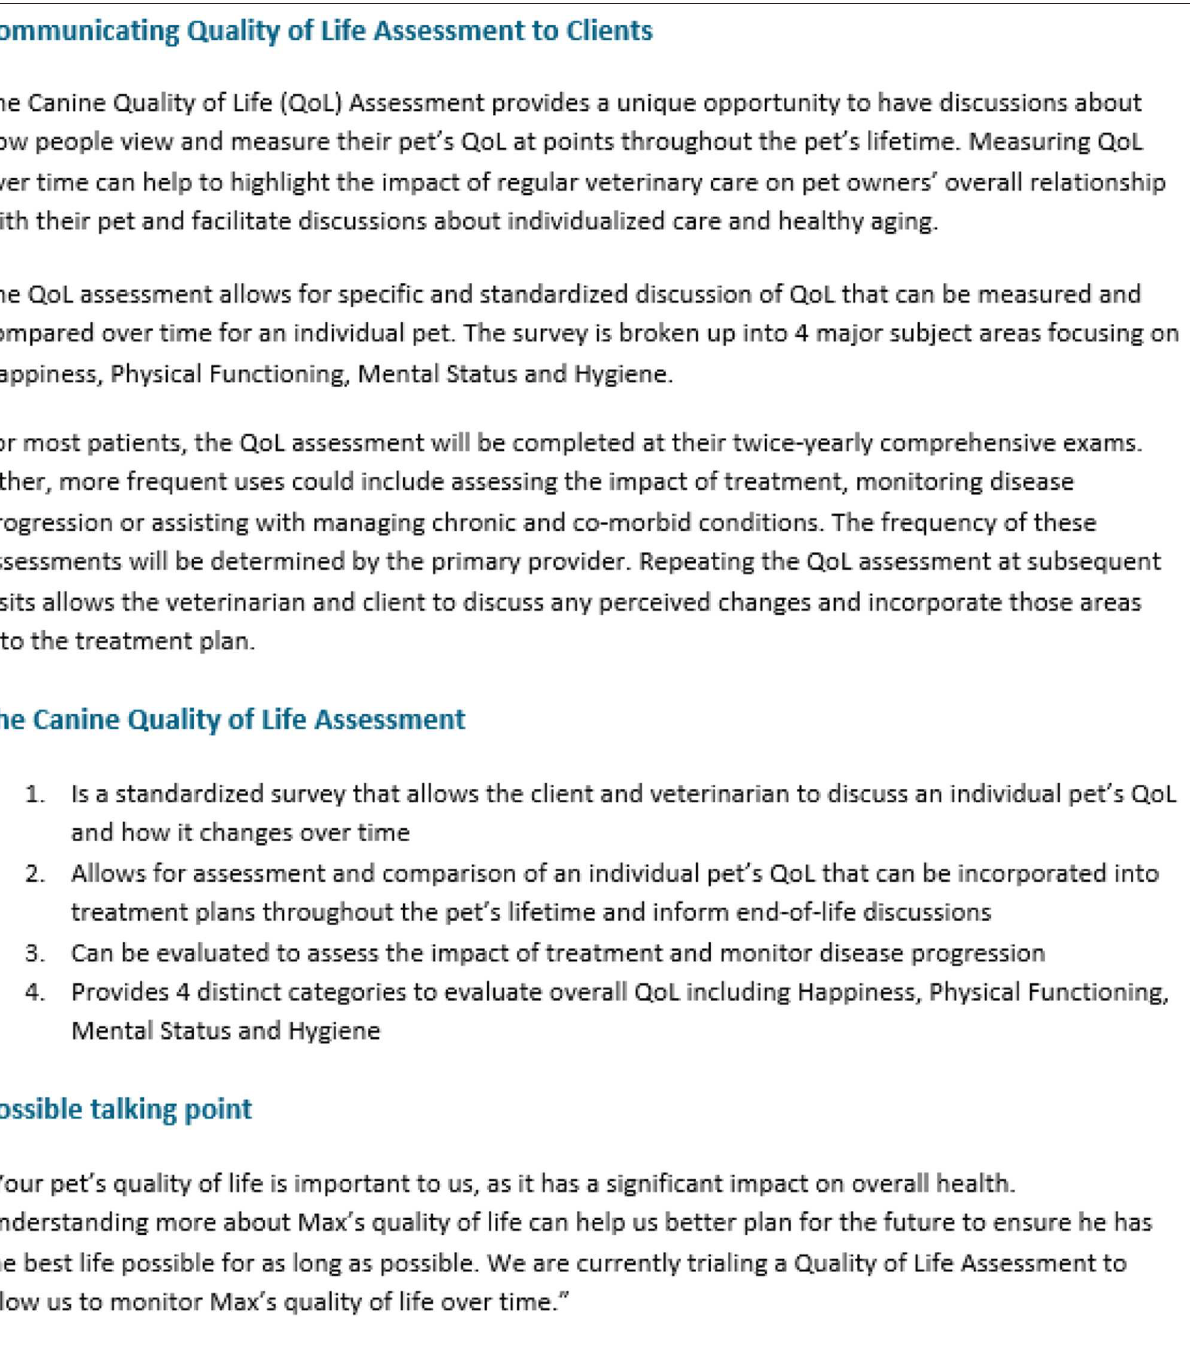
statistical correction for multiple testing was performed. The Canine HRQOL survey was completed by pet owners at only one timepoint, and since the tool was developed for longitudinal